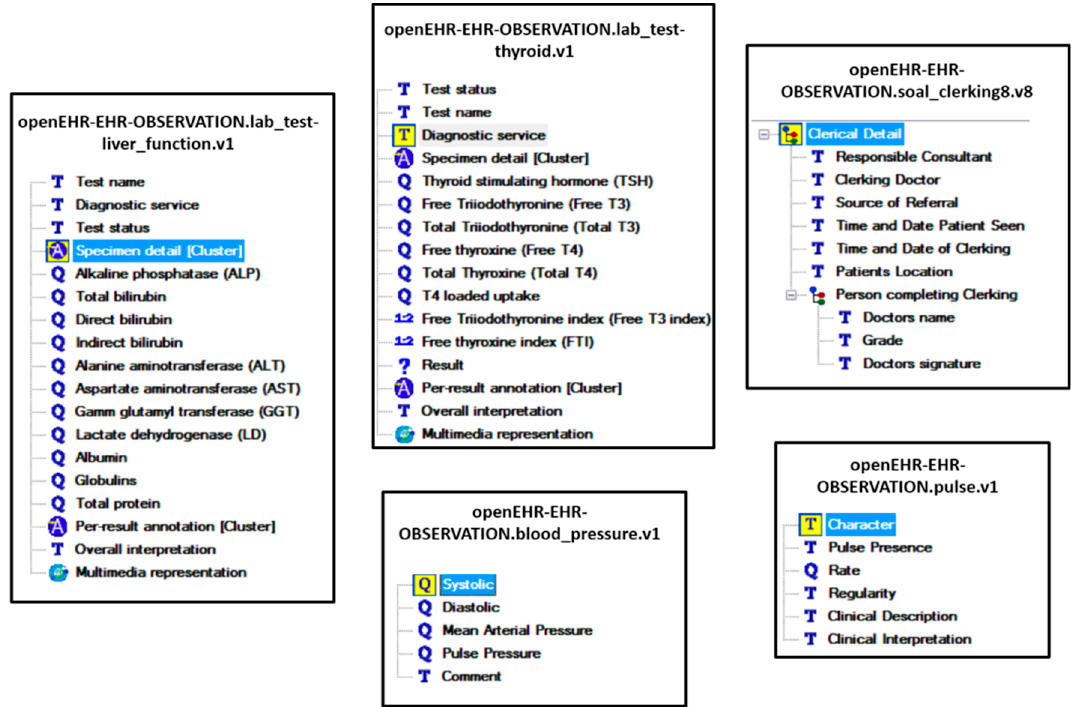
Figure A1. The data part of various archetypes used for data collection (T signifies TEXT (textual) data type and Q signifies QUANTITY (quantifiable) data type defined in RM of openEHR).